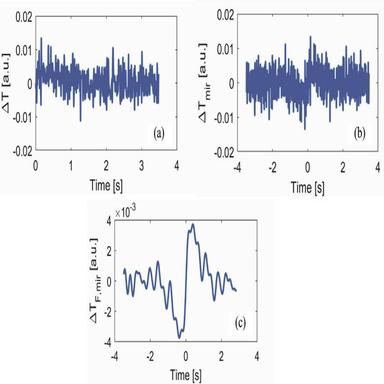
(a) Input thermal contrast with measurement noise and (b) corresponding mirrored signal. (c) Result of the filter on the mirrored input contrast.